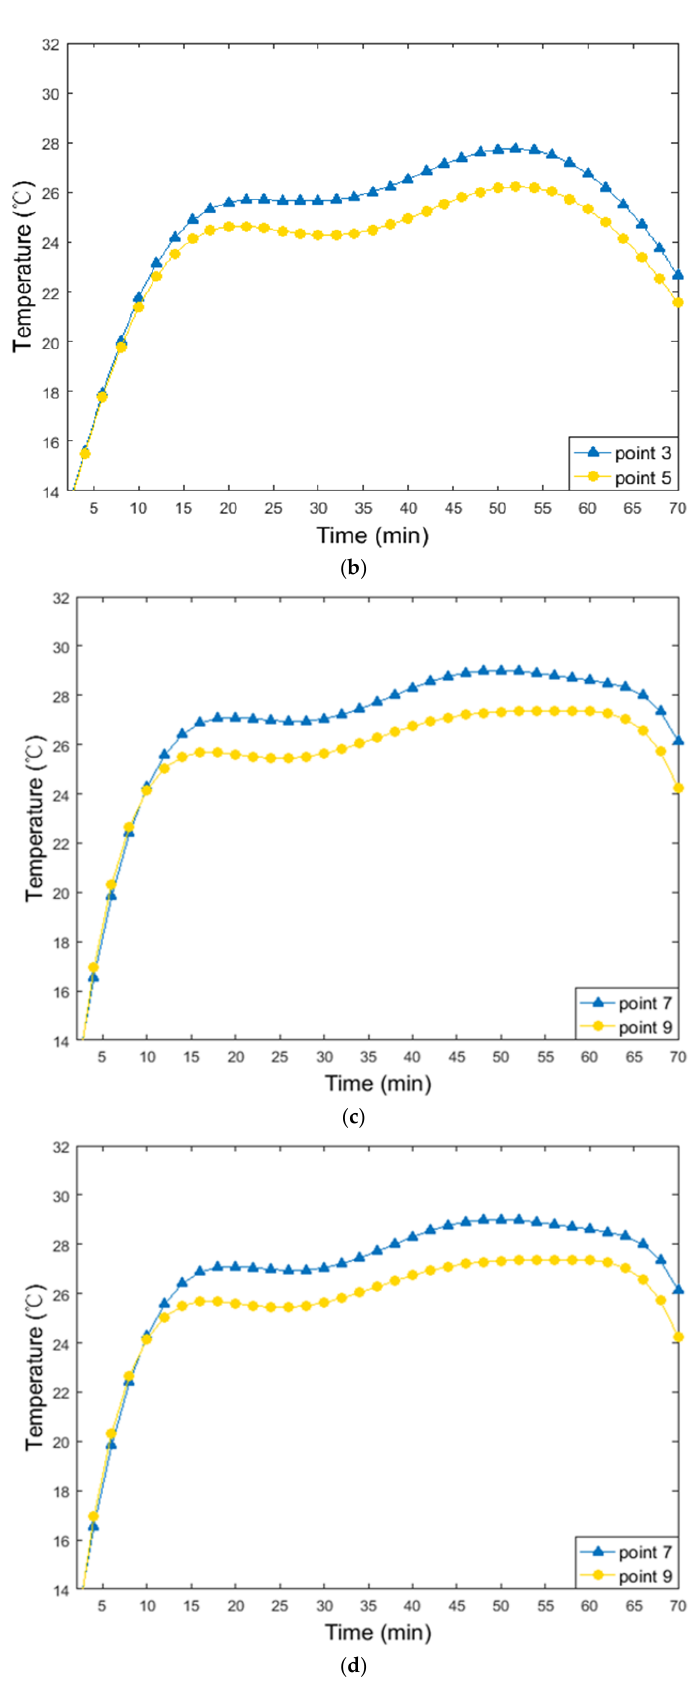
Figure 18. Temperature of the void boundary: ( a , c ) left side and ( b , d ) right side.